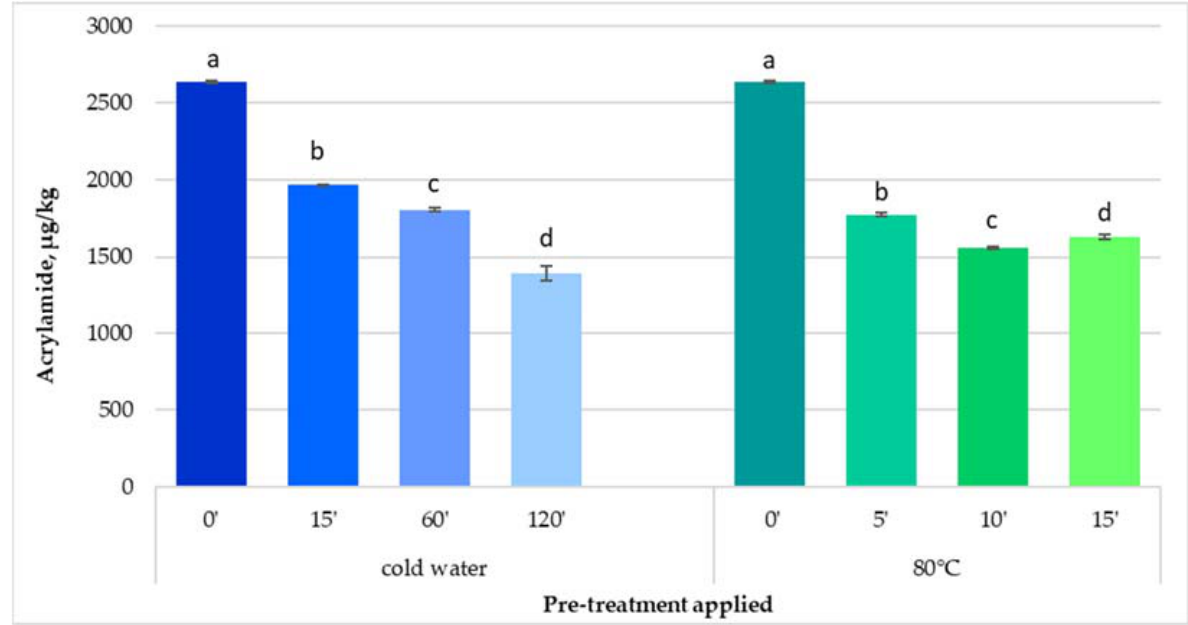
Figure 2. Effect of cold and hot water applied on potato strips on the acrylamide content of French fries fried in a fryer. Values followed by different letters in the same column for each pre-treatment are significantly different ( p < 0.05).